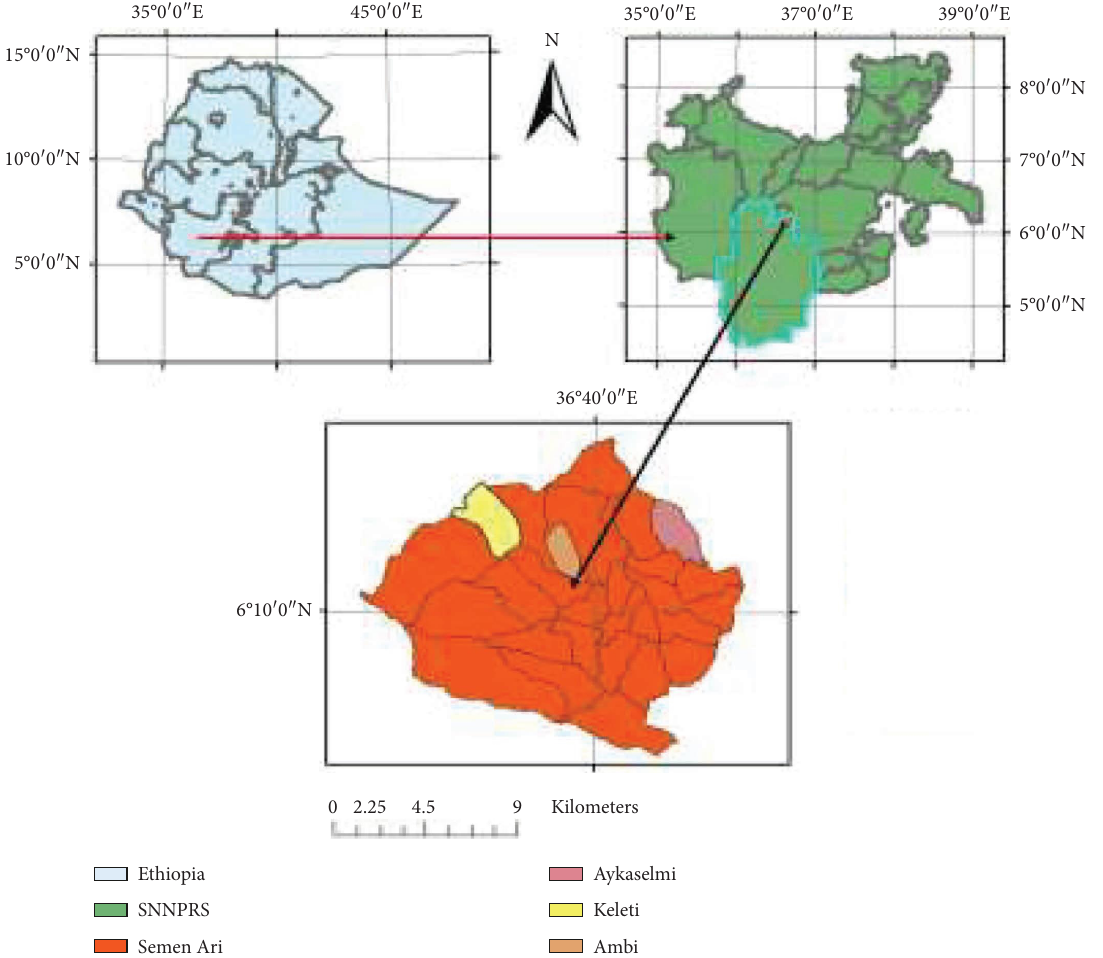
Figure 1: Map of the research